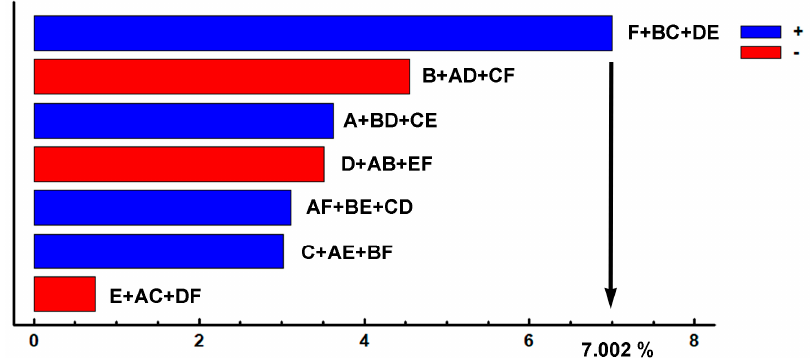
Figure 5. Pareto chart of the effects of each factor on the percentage by weight of K 2 carbides. Placing Factor F at its + 1 level (6-h tempering time) could produce a 7% increase in the weight percentage of carbides.